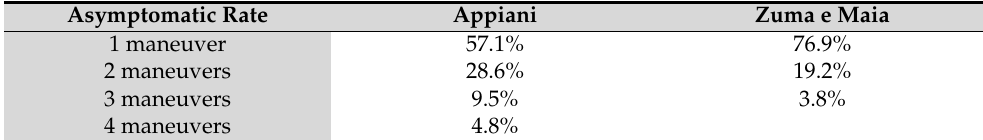
Table 1. Summarizes the number of maneuvers for each group during follow up in cases that were initially either symptomatic or asymptomatic with nystagmus.